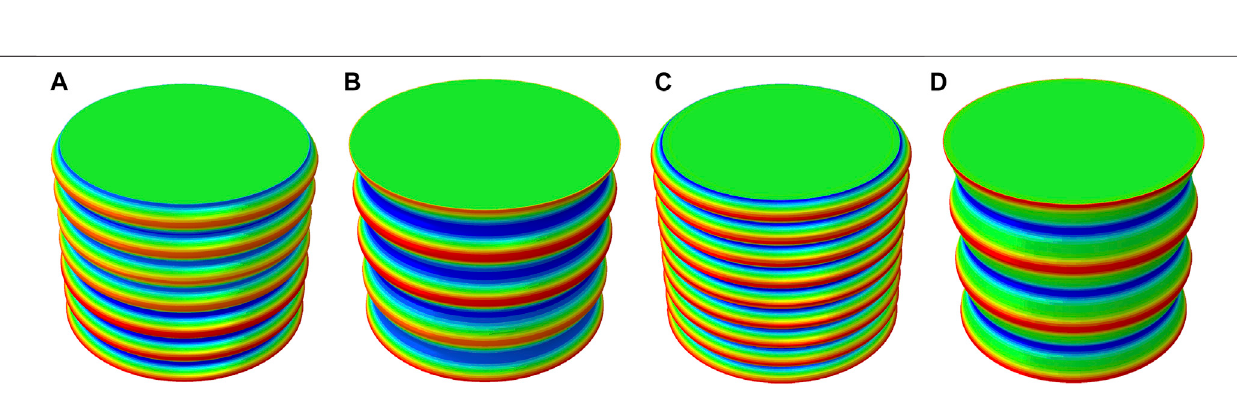
Frontiers in Mechanical Engineering |